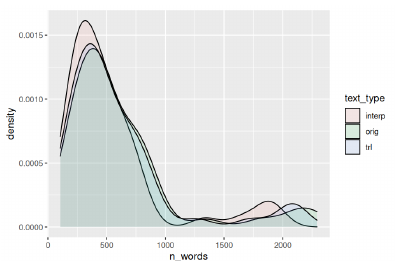
Figure A1. Density plots for the number of words per speech in the sample, for the three text types “original”, “translation” and “ interpretation”. The x-axis shows the number of words, the y-axis the probability density for the values on the x-axis.